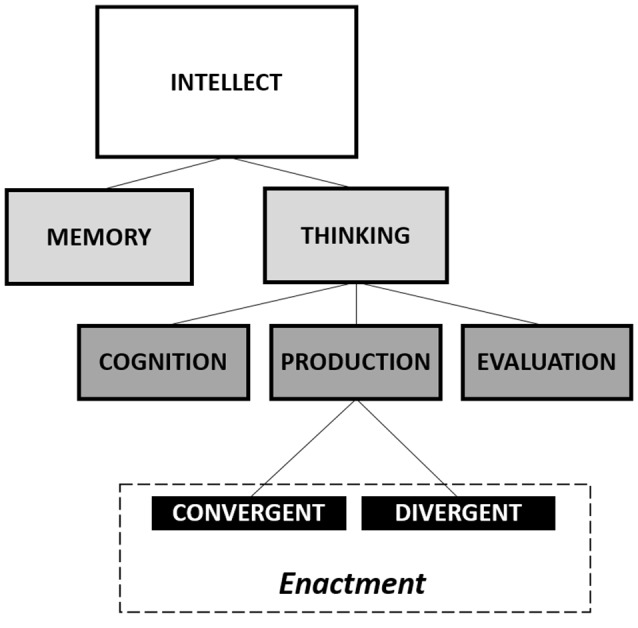
Guilford’s diagram of the intellectual factors. Modified from Guilford (1957).